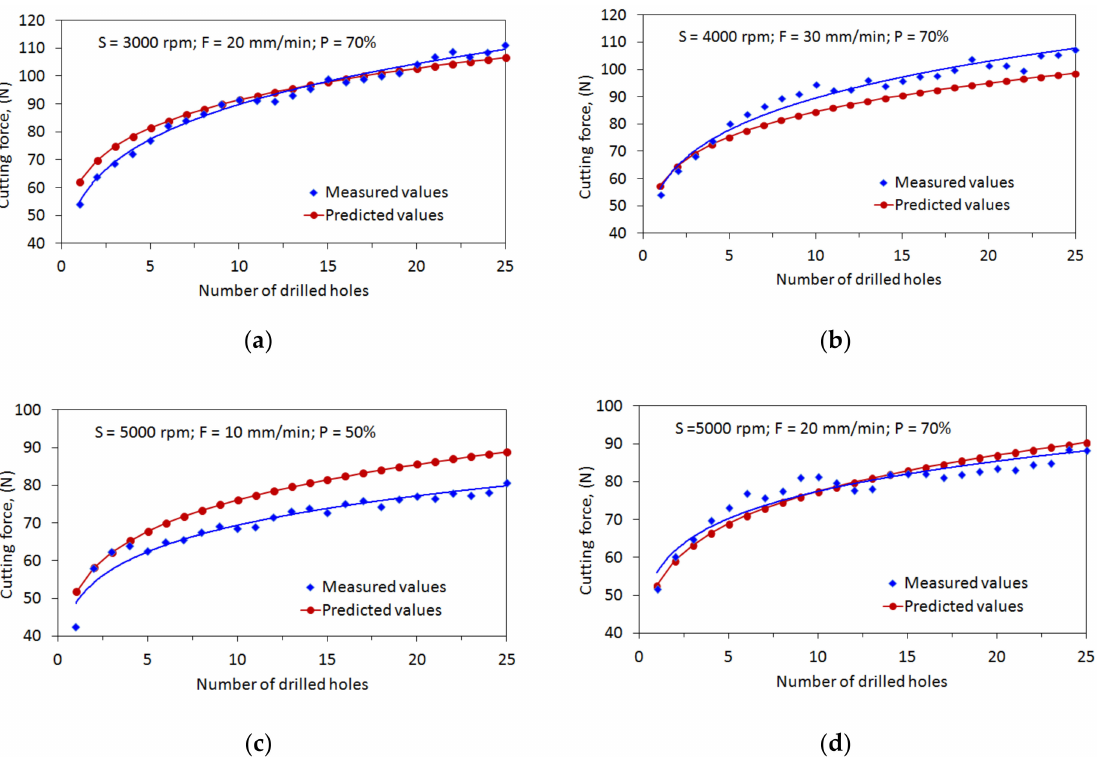
Figure 14. Comparisons of the evolutions of cutting force with drilling cycles (validation cases). ( a ) S = 3000 rpm; F = 20 mm/min; p = 70%, ( b ) S = 4000 rpm; F = 30 mm/min; p = 70%, ( c ) S = 5000 rpm; F = 10 mm/min; p = 50%, ( d ) S = 5000 rpm; F = 20 mm/min; p =